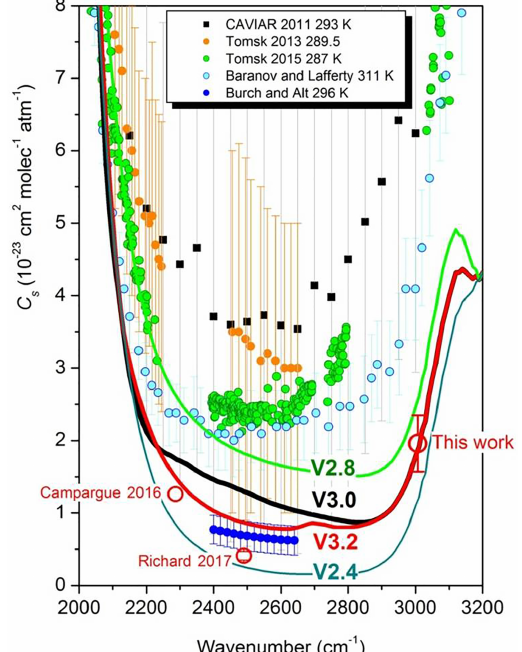
Figure 3. Overview comparison of the self-continuum cross-section of water vapour near room temperature. Solid lines show different versions of the MT_CKD model at 296K. Experimental results are obtained using different techniques, namely by OFCEAS, (red cir- cles, Campargue et al., 2016; Richard et al., 2017; this work); by FTS (light blue circles, Baranov and Lafferty, 2011); from CAVIAR (black squares, Ptashnik et al., 2011a); from Tomsk2013 (orange circles; Ptashnik et al., 2013), from Tomsk2015 (green circles; Ptashnik et al., 2015) and with a grating spectrograph (dark blue circles, Burch and Alt (1984)). Note that the plotted experimental results correspond to different temperature values (see temperature values given in the insert). The temperature of the OFCEAS results are 296.15, and 297.3 and 298.15K, for Campargue et al. (2016), Richard et al. (2017) and this work, respectively. The 30–50% er- ror bars on Tomsk2015 values are omitted for